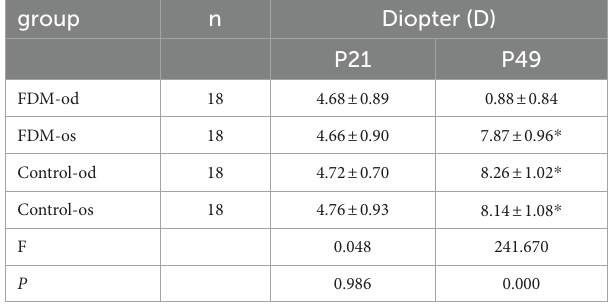
FDM: form-deprivation myopia; OD: oculus dexter; OS: oculus sinister. * indicate P <